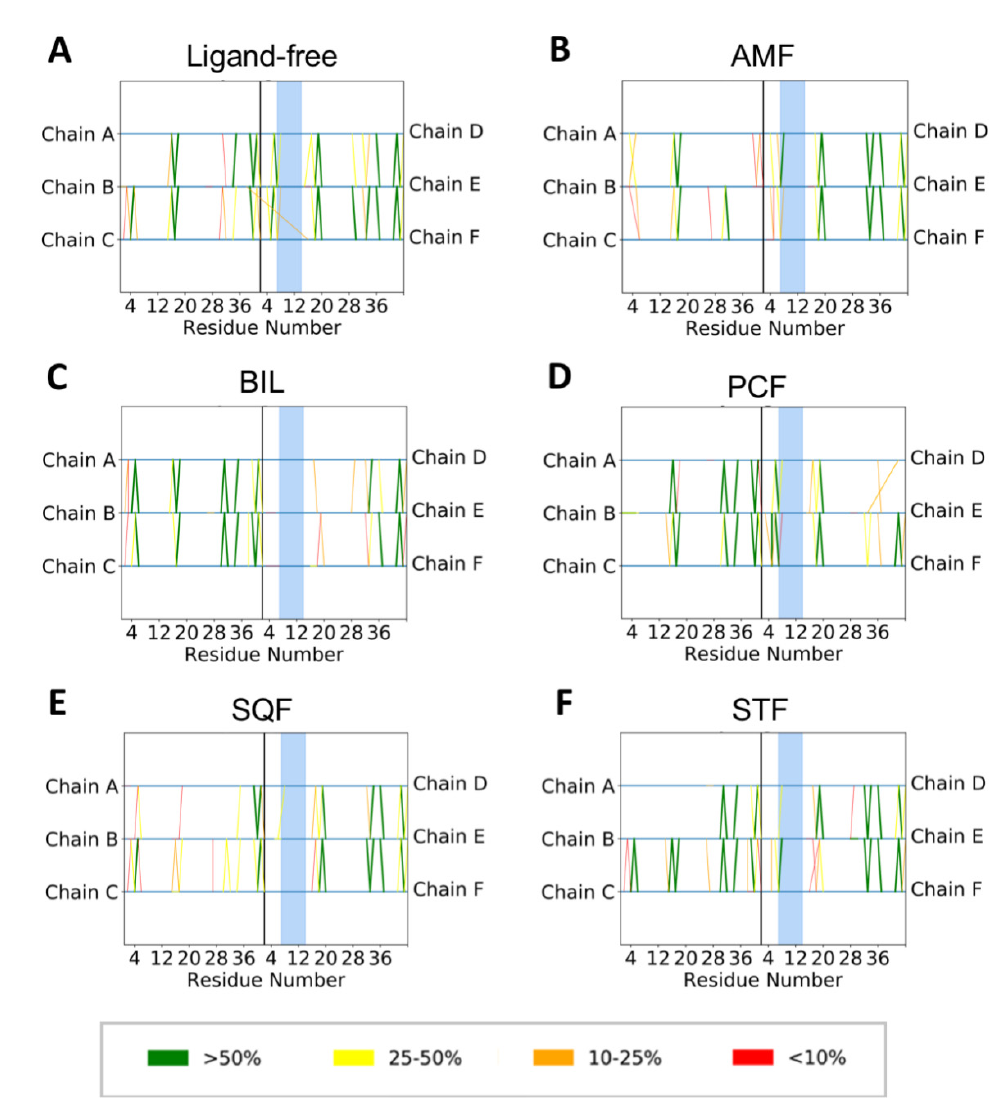
Figure 10. Protein backbone hydrogen bonding analysis derived from simulations of A β 42 with ( A ) no ligand, ( B ) amentoflavone (AMF), ( C ) bilobetin (BIL), ( D ) podocarpusflavone (PCF), ( E ) sequoiaflavone (SQF), and ( F ) sotetsuflavone (STF). Hydrogen bonds percentages were calculated over the each 1.0 μ s simulation, and were categorized by the percent of frames with backbone hydrogen bonds present: >50% (green), 25–50% (yellow), 10–25% (orange) and less than 10% (red). Each line depicted shows a backbone hydrogen bond present during the simulation to and from one of the six peptides (Chains A – F ) from the original structure (PDB 2NAO). The blue highlighted region depicts the area with the most direct contact with each ligand from docking. Larger images of each panel with amino acids 1–42 listed explicitly can be found in the SI.